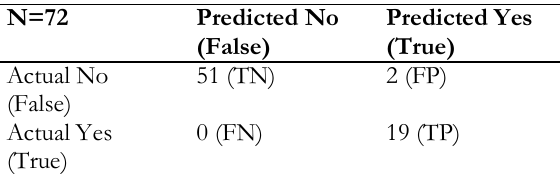
Table 6. Confusion